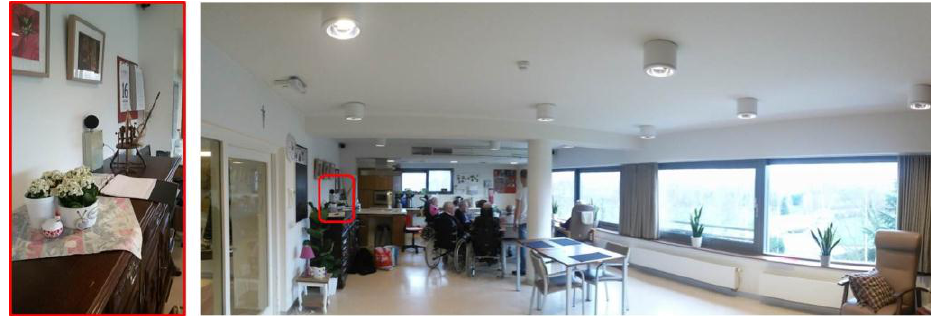
Figure 1. An example of installation of a node in one of the living rooms of the study. The right figure shows the overall context, the left figure shows a close-up of the red box in the right figure.